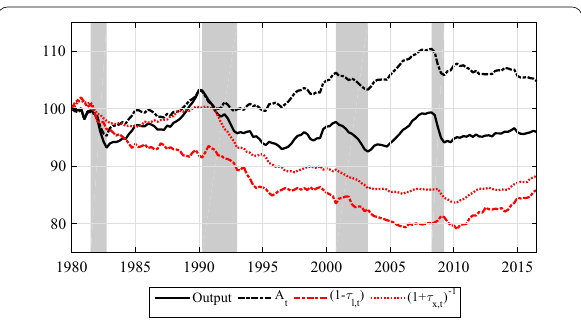
Fig. 10 Robustness: Output and wedges for ν =